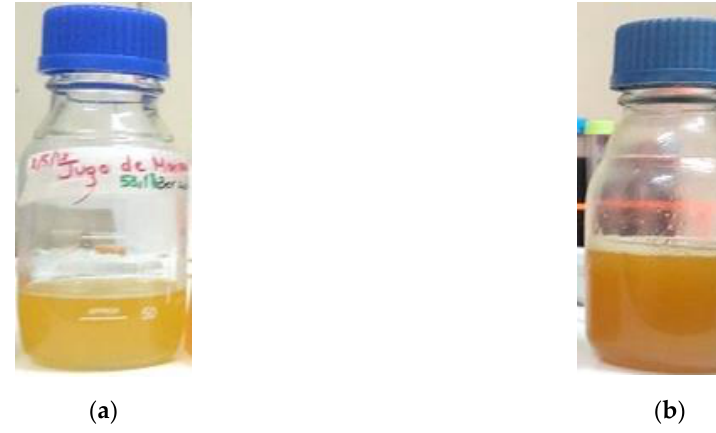
Figure 3. Samples of apple juice: ( a ) fresh juice; ( b ) cryoconcentrated sample (3rd cycle).